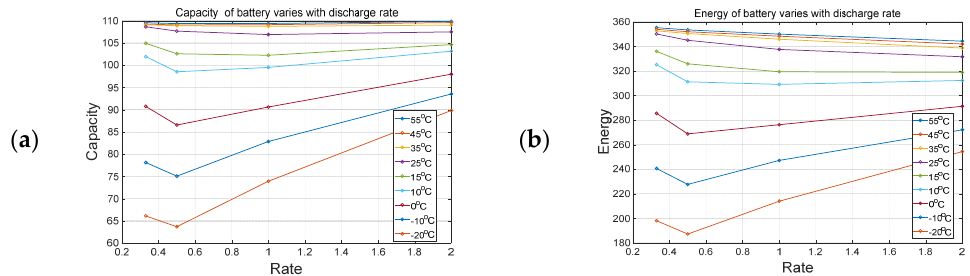
Figure 5. Variation of capacity and energy of battery with ambient temperature and charging rate.